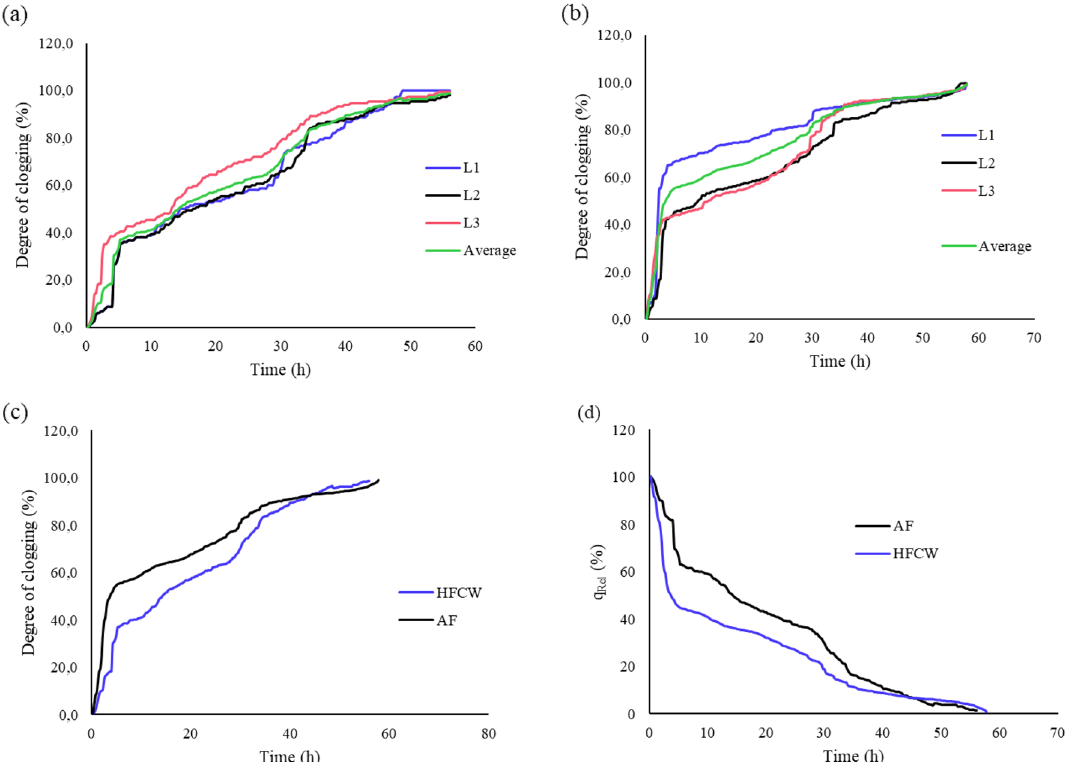
Figure 5. Degree of clogging ( DC ) for ( a ) AF effluent, ( b ) HFCW effluent, ( c ) DC vs q Ave for AF and HFCW effluents, and ( d ) Relative discharge ( q rel ) plots for AF and HFCW